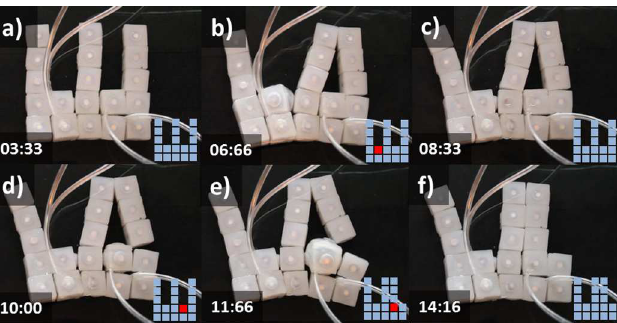
Fig 14. Self-Reconfiguration on setup 2A-17U, First Actuation Pattern. First part demonstrating how varyingactuationpattern results in different configurations. A group of 19 modulesis initiallyconfigured into an ‘E’ shape (a). In this case the lower-left moduleis first inflated (b) and then the lower-rightmoduleis inflated (d,e). This actuationpattern results in a final ‘F’ shape. Time stamps are in the format